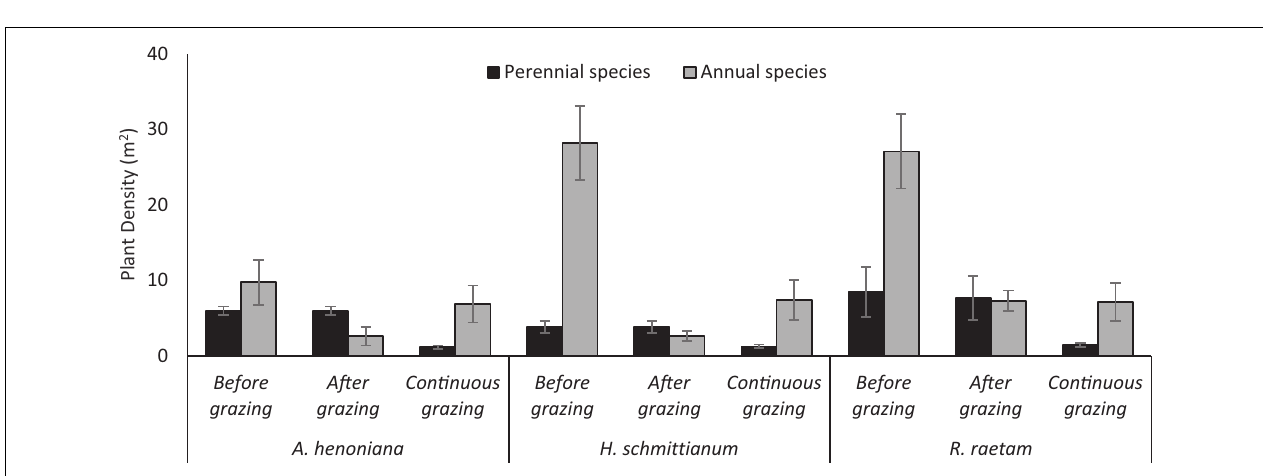
FIGURE 3 | Perennial and annual species density in 2 years protected plant communities ( A. henoniana, H. schmittianum , and R. raetam ) sites before and after subjecting to 1 week of intense grazing compared to continuous grazing sites in Tataouine, Tunisia.